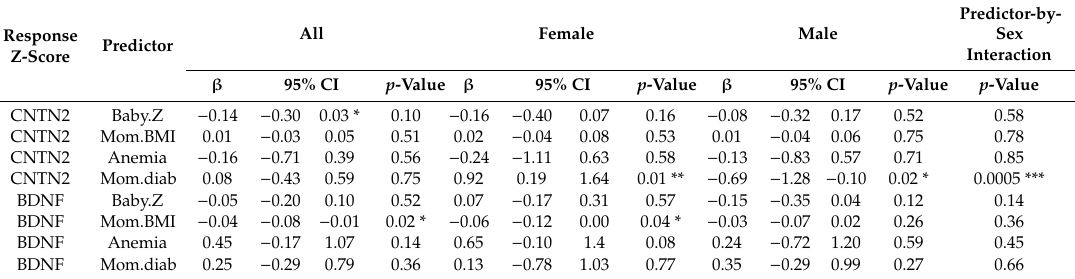
Table 3. Neonatal risk factors as predictors of CNTN2 and BDNF.